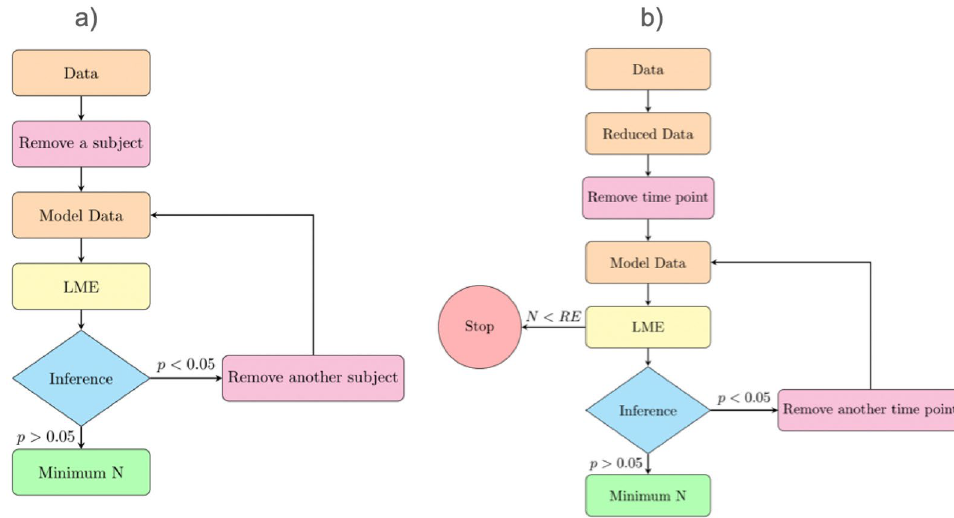
Figure 1. Simulations’ scheme ( a ) Strategy for minimum N simulations. The initial data is dataset 1 or dataset 2. ( b ) Strategy of the simulation of missing time points. RE = random